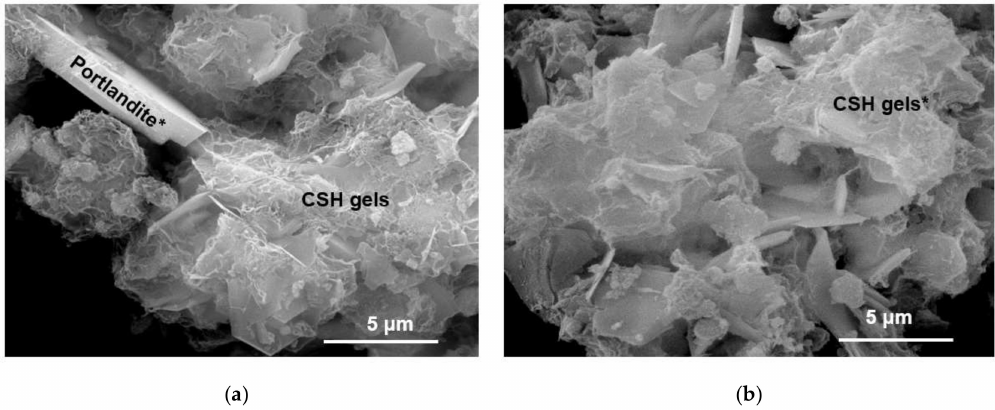
Figure 7. Solid phases present at 360 days of hydration reaction (*indicates the analysis point listed in Table 4). ( a ) Portlandite and C-S-H gels; ( b ) C-S-H gels. Table 4. Chemical analysis by EDX (* indicates the analysis point from Figures 6 and